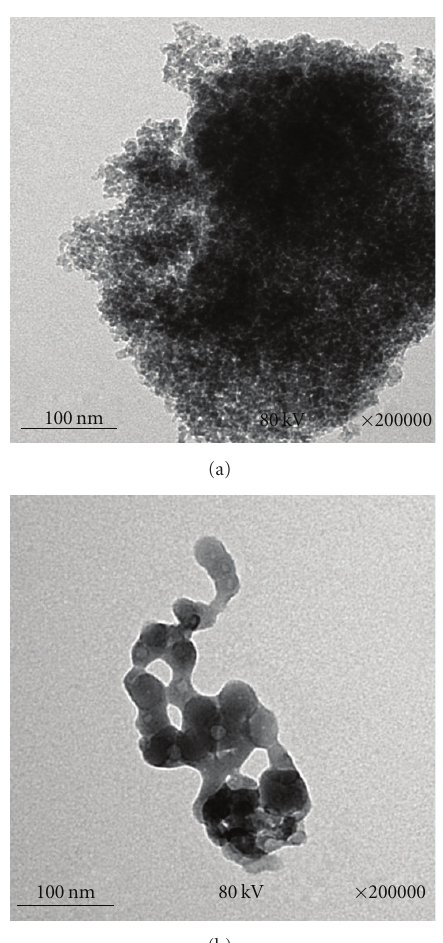
Figure 10: TEM micrographs of (a) MG 3 -Cu and (b) MG 3